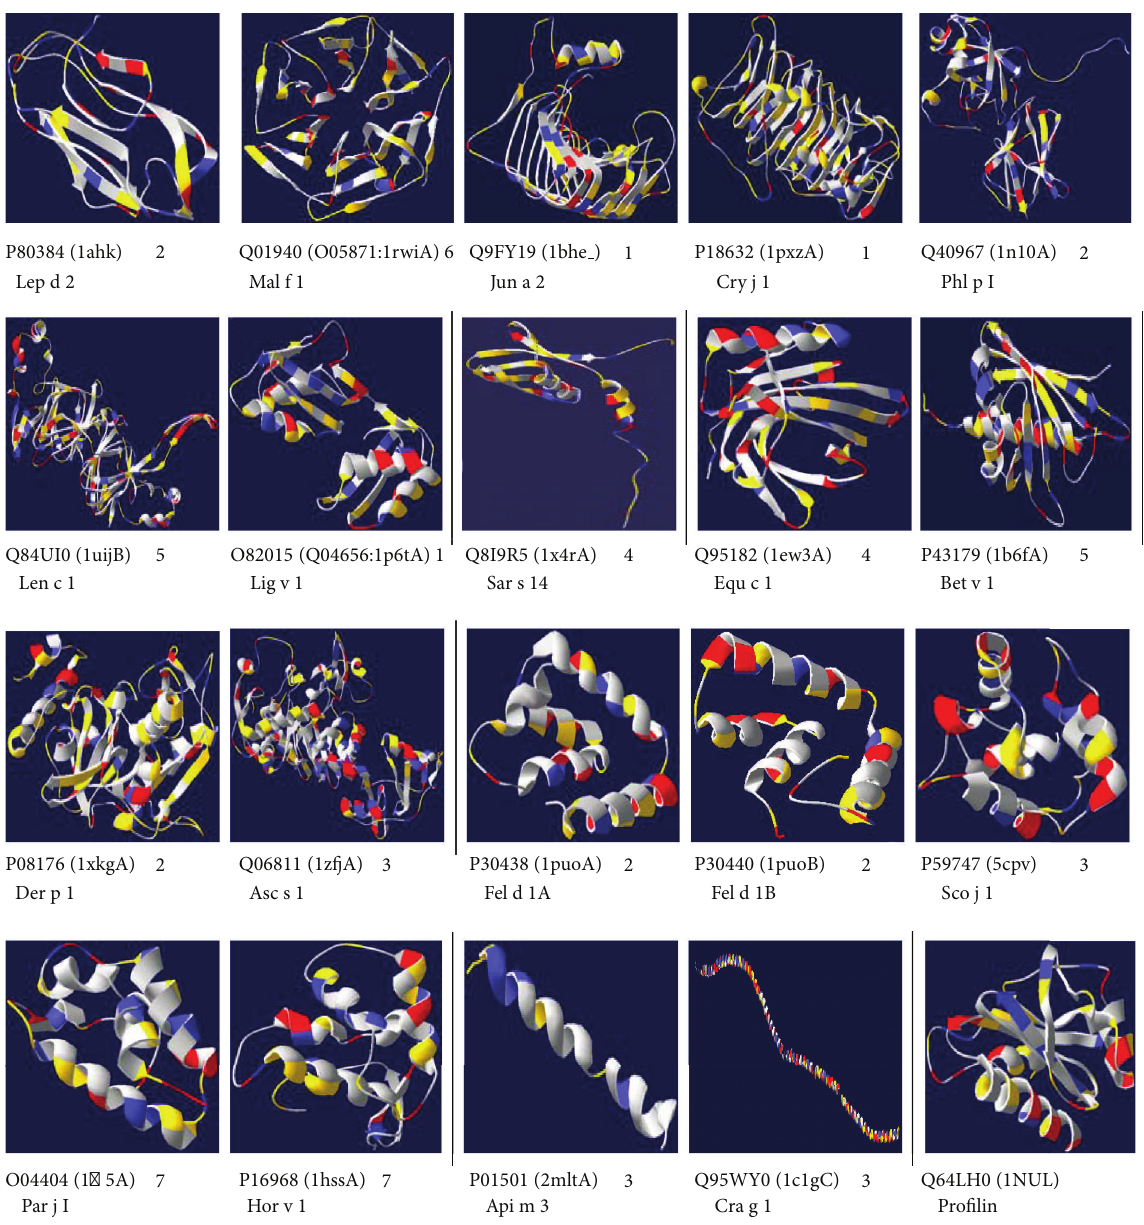
Figure 5: Ribbon diagrams of profilin (Q64LH0) and 19 out of the 21 major representative allergens subtracted. The 7 structural classes are separated by vertical lines. PDB codes are shown in brackets; the following numbers indicate the initial sequence clustering groups. Q64LH0 was not retrieved as a major allergen thus without initial cluster number. Q9M5X7 and Q40237 were omitted for space